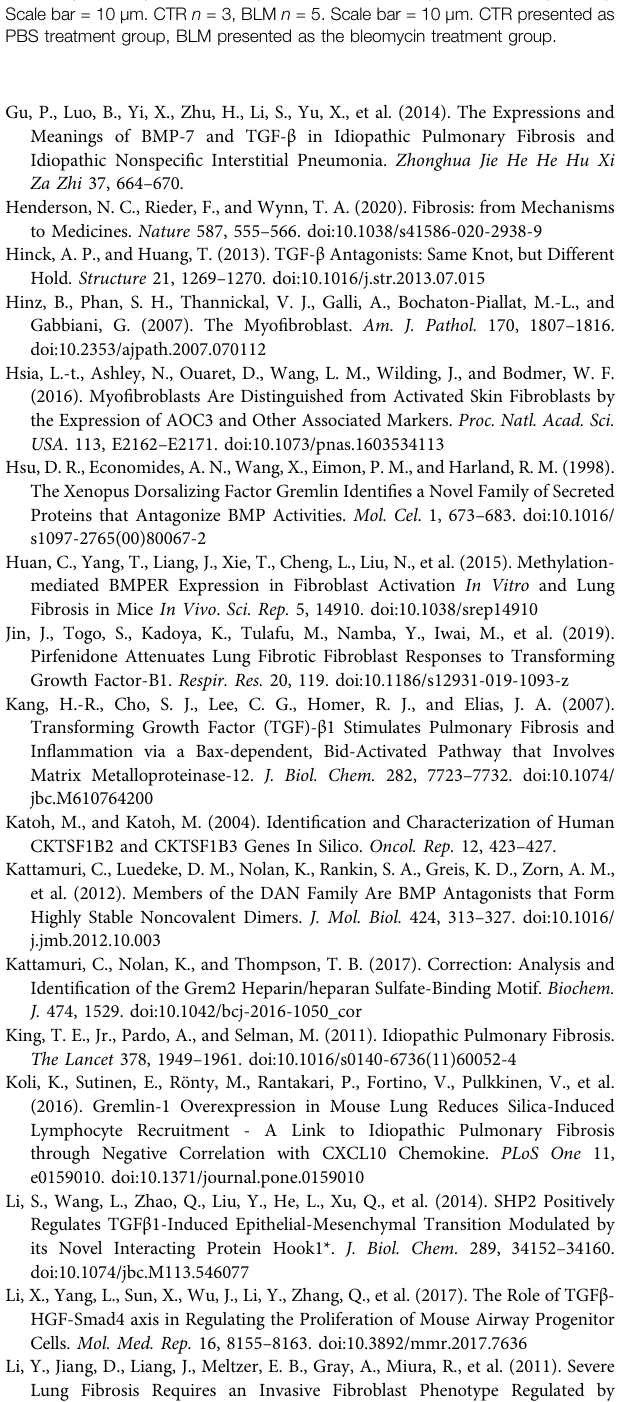
Supplementary Figure S6 | p -Smad1 is upregulated in activated mice lung fi broblasts after bleomycin treatment. (A) Transwell cell migration experiment of mice lung fi broblasts after PBS or bleomycin treatment. The lower chamber was stained with crystal violet 24 h later, and three fi elds were randomly selected for imaging under 100x magni fi cation. Scale bar (cid:2) 100 μ m. CTR n (cid:2) 2, BLM n (cid:2) 2. (B) The value of OD570 after elution of crystal violet, normalized to that of the control group,** p (cid:2) 0.001.Unpairedstudentttest. (C) Transwellcellinvasionexperimentof mice lung fi broblasts after PBS or bleomycin treatment. The lower chamber was stained with crystal violet 24 h later, and three fi elds were randomly selected for imaging under 100x magni fi cation. Scale bar (cid:2) 100 μ m. CTR n (cid:2) 2, BLM n (cid:2) 2. (D) The value of OD570 after elution of crystal violet, normalized to that of the control